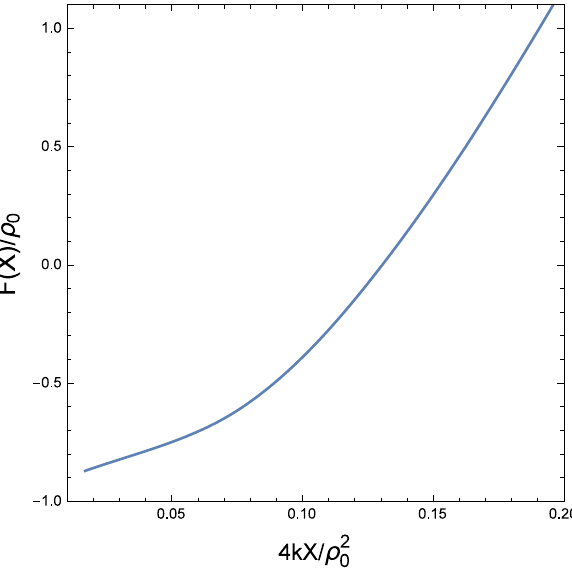
Fig. 6 Here the reconstructed F ( X ) is shown based on the parametrization w 0 + ln ( 1 + z ) withthebestfitvaluesof w 0 ,w a obtained from SNIa data points. The function is stable throughout the z range. ( c 2 s >